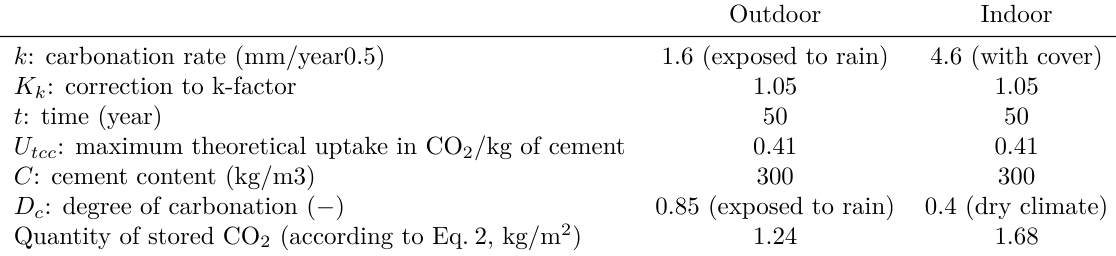
Table 5. Values considered for the